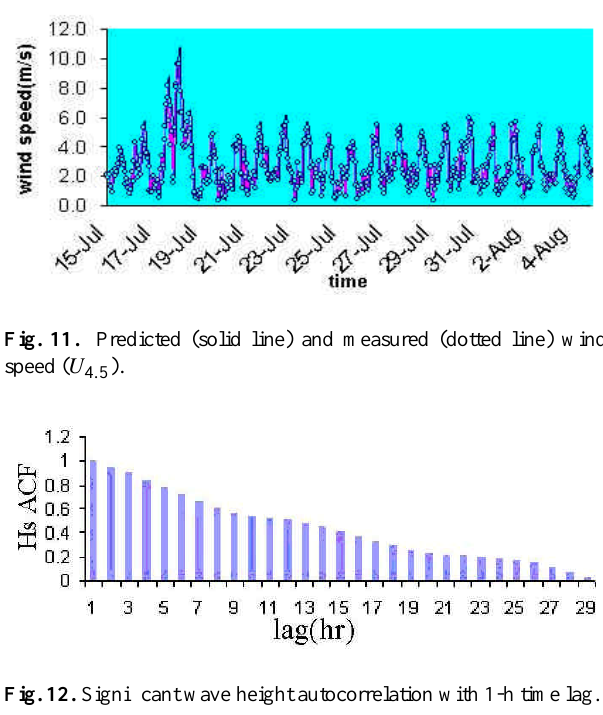
Figure10. Wind speed partial auto correlation with 1hr time lag